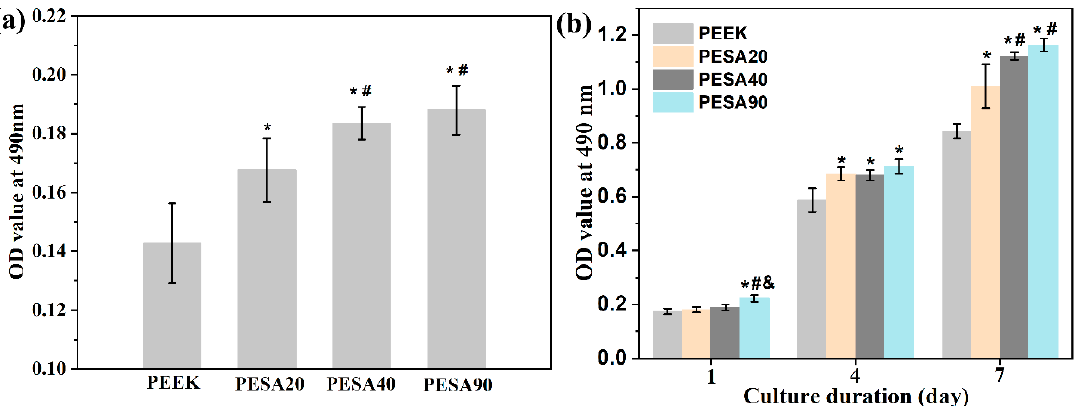
Figure 6. The results of MC3T3-E1 osteoblast adhesion ( a ) and proliferation ( b ) on different samples measured using MTT after 4 h, and 1, 4, and 7 d of culture. Statistically significant differences were indicated by * p < 0.05 compared with the PEEK, # p < 0.05 compared with the PESA20 and & p < 0.05 compared with the PESA40. All data represent the mean value ± standard deviation ( n = 4 per group).